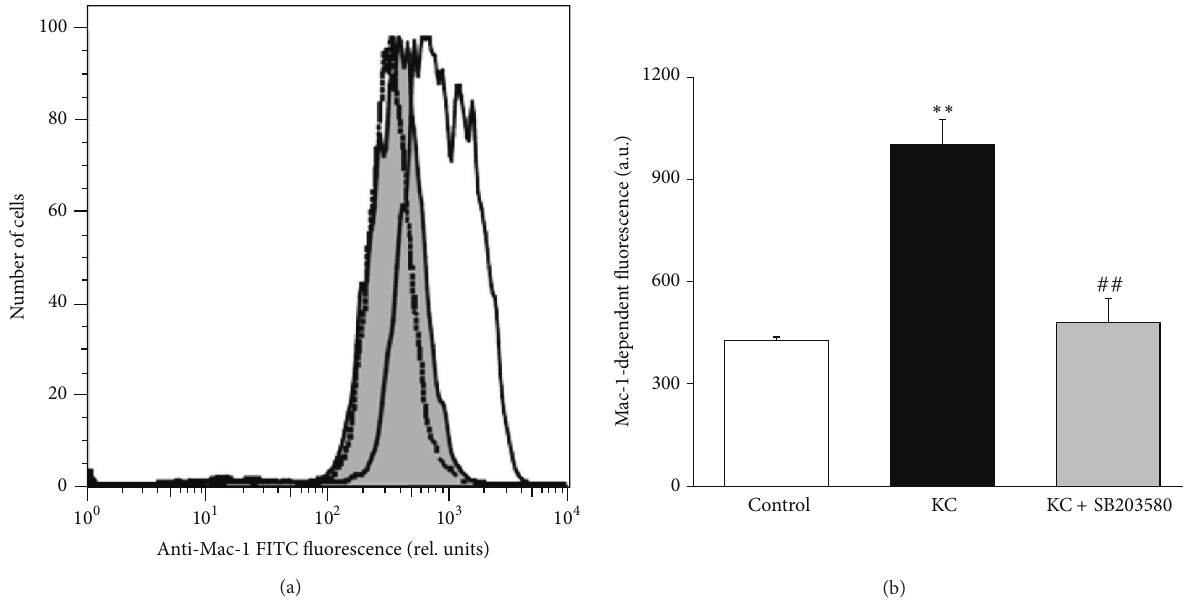
Figure 5: Effect of SB203580 on neutrophil Mac-1 expression in vitro . (a) Original histogram of Mac-1-dependent fluorescence in bone- marrow-derived neutrophils in the absence (gray shadow) or in the presence of stimulation with KC (5nM for 10min; black line). Neutrophils treated with p38 MAPK inhibitor SB203580 (10 𝜇 M for 40min) are shown as a dotted line. (b) Means ± SEM ( 𝑛 = 3 ) of Mac-1-dependent fluorescence expressed as geomeans in unstimulated neutrophils (control; white bar) and in neutrophils stimulated with KC (black bar) and with KC plus SB203580 (gray bar). ∗∗ indicates significant difference ( 𝑃 < 0.01 ) from the control without KC stimulation and ## indicates significant difference ( 𝑃 < 0.01 ) from KC stimulation without SB203580 ( t -test).